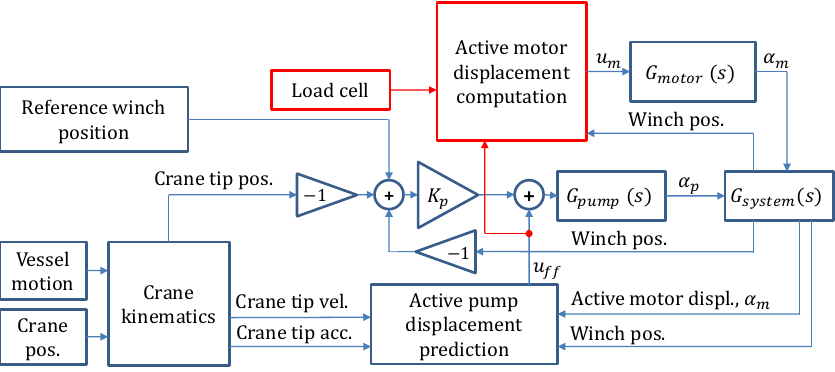
Figure 2. The new control structure.